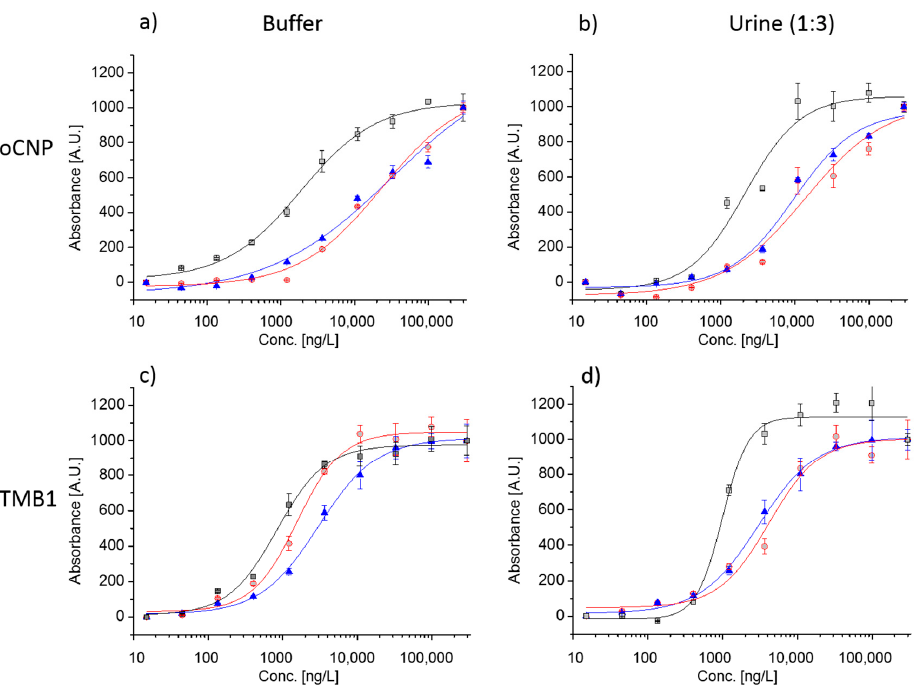
Figure 5. Normalized colorimetric signals in ( a ) assay buffer with labels oCNPs (Assay Scheme III); ( b ) in urine (1:3) with oCNPs ( c ) in assay buffer using HRP (Assay Scheme VI); ( d ) in urine (1:3) with HRP. Calibration curves for 0 to 295 µg/L: IL8, VEGF, and DCN; including standard deviations of three replicates. The blank signal (0 ng/L) is represented by 15 ng/L on the log scale.